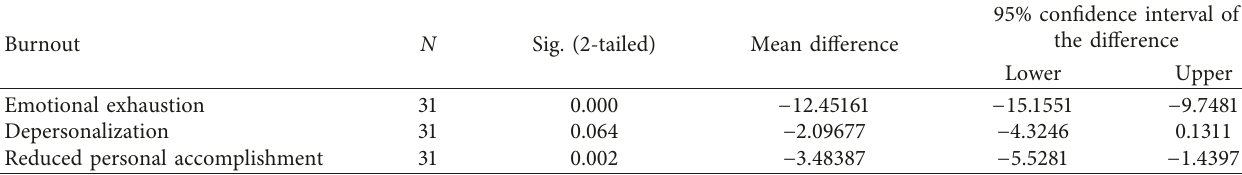
Table 1: Statistic and one-sample t -test for burnout dimensions.